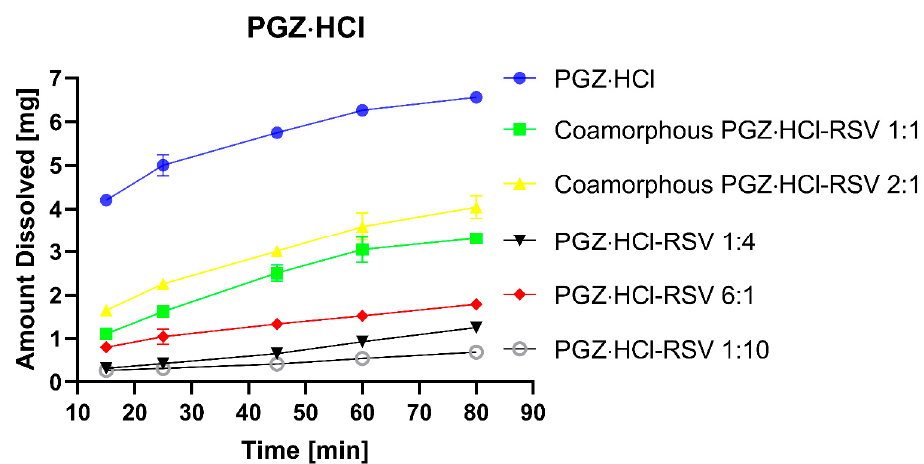
Figure 12. Dissolution profiles evaluating the release of PGZ · HCl. Pure PGZ · HCl, coamorphous forms of PGZ · HCl -RSV (2:1 and 1:1), and solid forms of PGZ · HCl-RSV (1:4, 6:1, and 1:10). Table 8. K int values for the synchronized release of pure RSV and PGZ·HCl. Likewise, coamorphous forms of PGZ·HCl -RSV (2:1 and 1:1) and solid forms of PGZ·HCl-RSV (1:4, 6:1, and 1:10).